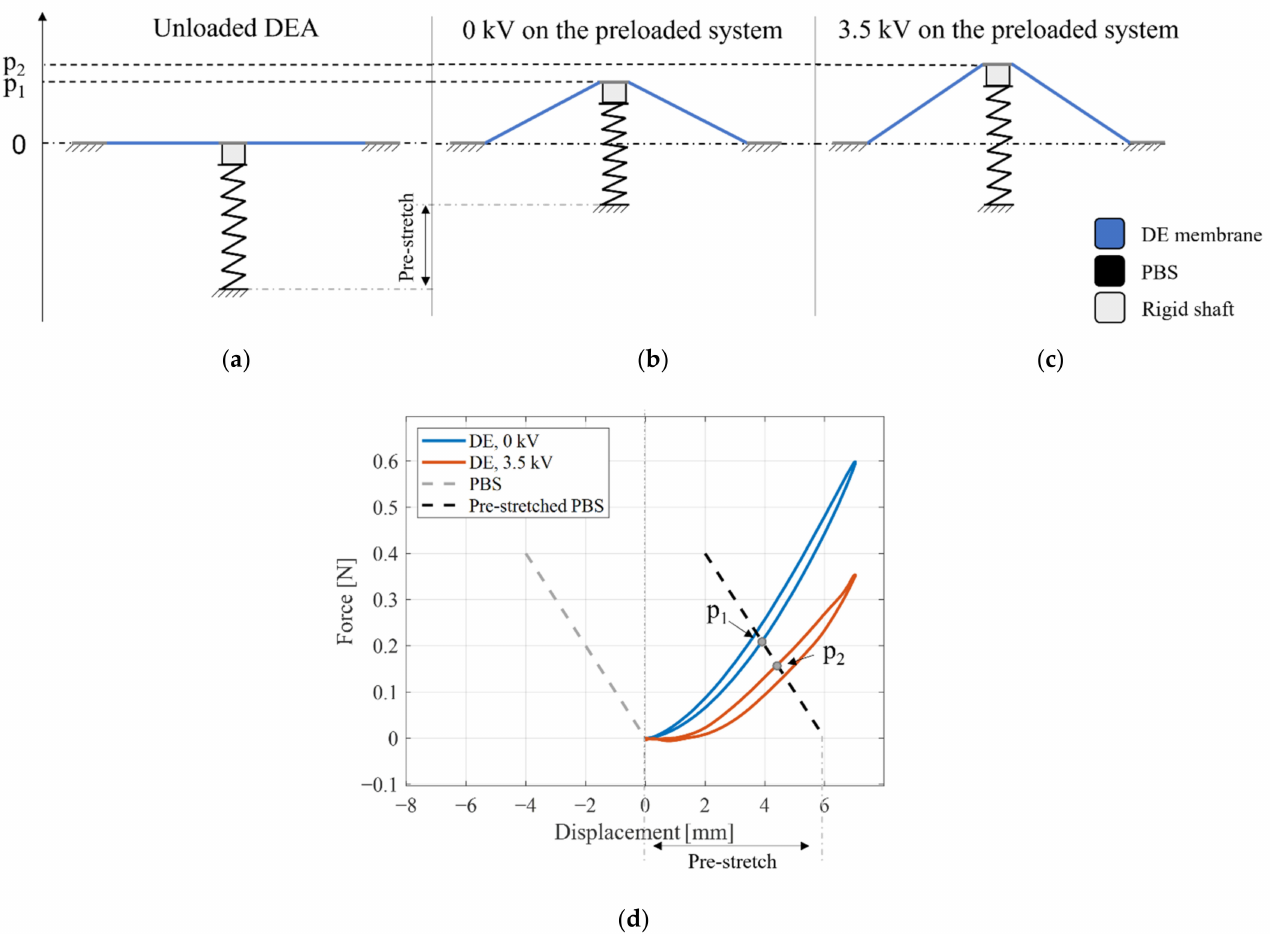
Figure 4. ( a – c ) Sketch of the DEA actuator composed by a DE membrane coupled with a PBS element, for three different configurations. ( d ) Actuator force equilibrium analysis, intersection points p1 and p2 represents the equilibrium states obtained by switching the